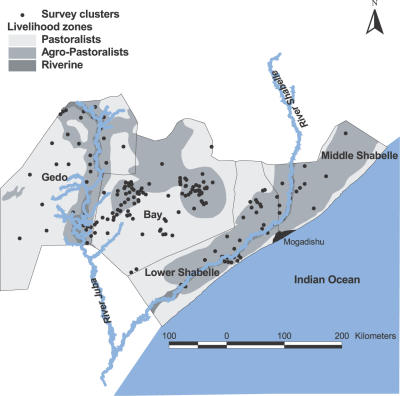
Map of South-Central Somalia regions showing the distribution of clusters where surveys were undertaken by livelihood zone.6/197 clusters could not be geo-located and therefore not shown in the figure.